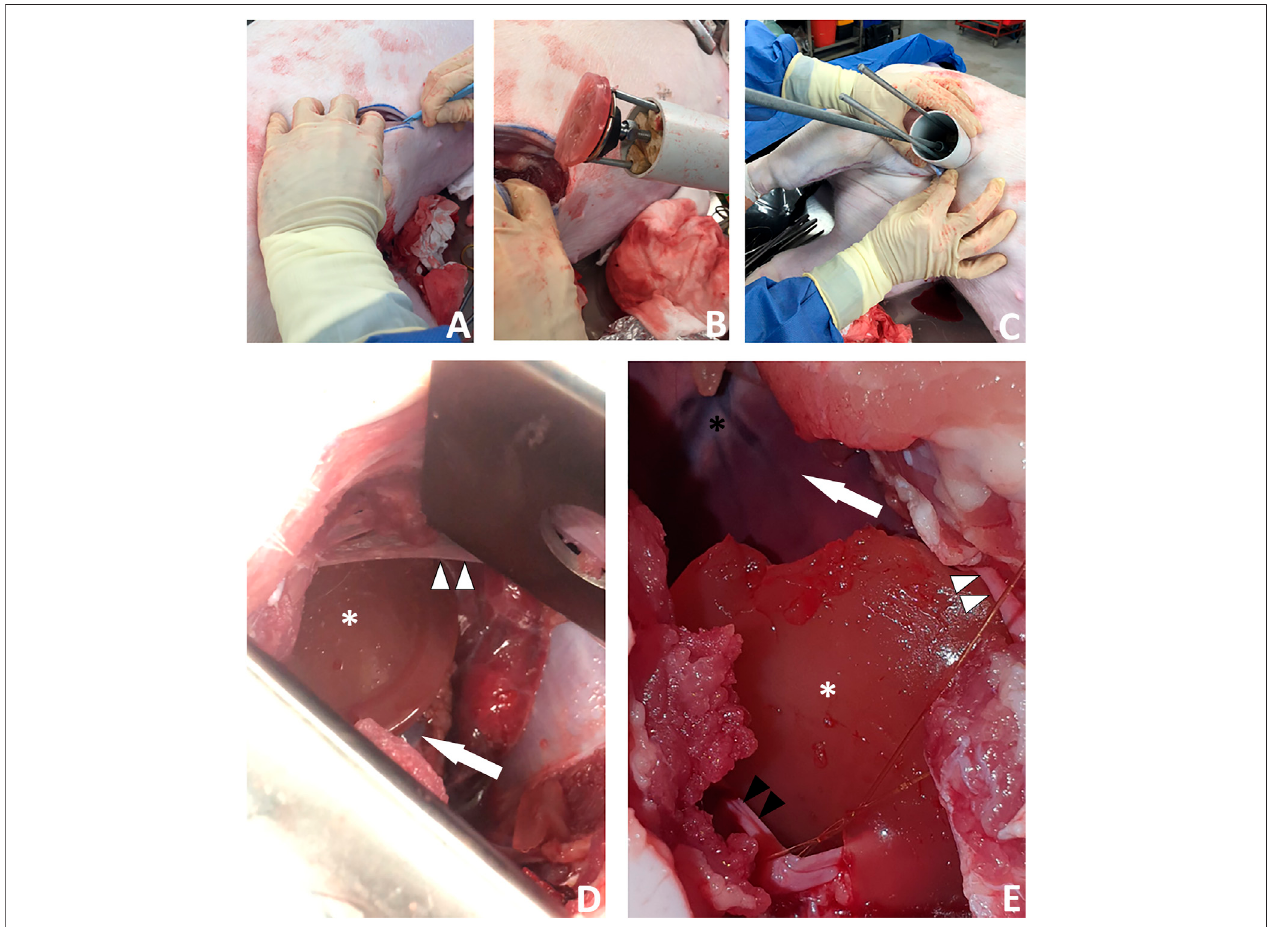
FIGURE 9 | A new surgical operation for epicardial patch transplantation using the HeartStamp — left postero-inferolateral approach without sheath. This surgery was performed once in real time to better simulate real surgical conditions and there were no complications. (A) A postero-inferolateral surgical incision was made in a fresh cadaver of a pig which had recently died of unrelated causes. The previously made left antero-lateral incision (the other approach we tested shown in Figure 8 ) is concealed under the surgeon ’ s left hand in the photograph shown in panel (A) — higher up and more towards the midline. (B) A moulded alginate/gelatin hydrogel patch was picked up by the instrument (without manual application) and is shown here adherent to the ring at the distal (patient) end of the HeartStamp instrument. The blackstampheadisseeninretractedpositionunderthepatch.TheHeartStampismovedintopositionbythesurgeon. (C) TheHeartStampisshowninposition,inserted through the incision in the chest wall (the 5 cm diameter HeartStamp cylindrical body fi ts the 5 cm incision). This entry route is similar (in location and size) to established approachesusedforuniportal(oneportforallsurgicalinstruments)VATS — atypeofkeyholesurgeryonthechest.Therodsareseenfromthecontrol(operator)endwith the two shorter rods being lateral and connected to the ring (distal end — inside the patient) and the longer rod being central and connected to the stamp. (D) For con fi rmationthatthepatchwassuccessfullytransplanted(asshownin SupplementaryVideoS4 ),weusedaretractortoopenthewoundandvisualizethepatch(white asterisk)ontheapexoftheheart(whitearrow).Athinbeamofpericardiumisseensuperiorly(whitearrowheads). (E) Close-upviewofthepatch(whiteasterisk)shownon the heart apex (not shown — concealed by the patch) after we opened the chest fully to examine the patch location. Left/superior pericardial tissue is seen (white arrowheads) and right/inferior pericardium (black arrowheads) is visualized attached to a surgical suture. The heart is seen in the background of the image (white arrow) along with the anterior interventricular (left anterior descending) blood vessels (black asterisk).